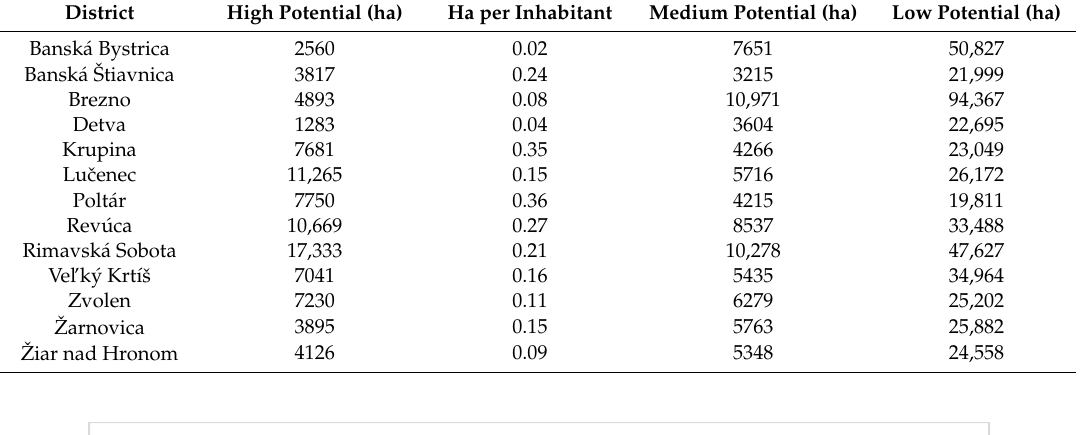
Table 4. Distribution of the potential for mushroom classes within districts of the region.